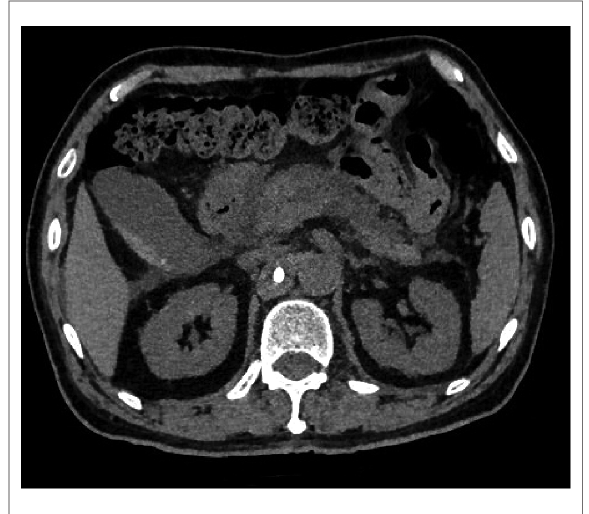
FIGURE 3 Abdominal CT showing obvious peripancreatic effusion with fuzzy edges, and high density bone cement shadow was seen in the right anterior of L1 vertebra.